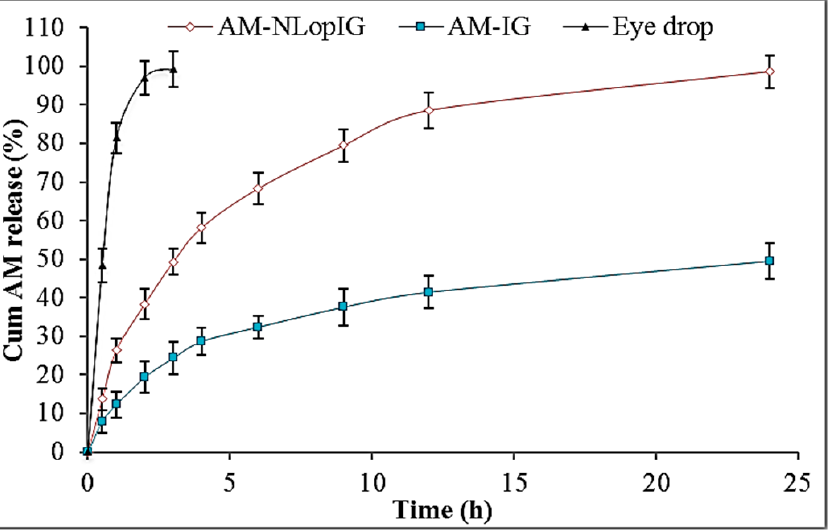
Figure 6. In vitro release data of the Azithromycin nano lipid carrier (AM-NLop), Azithromycin nano lipid carrier-based in situ gel (AM-NLopIG), and AM eye drop. The tests were performed in triplicate and data are shown as mean ±